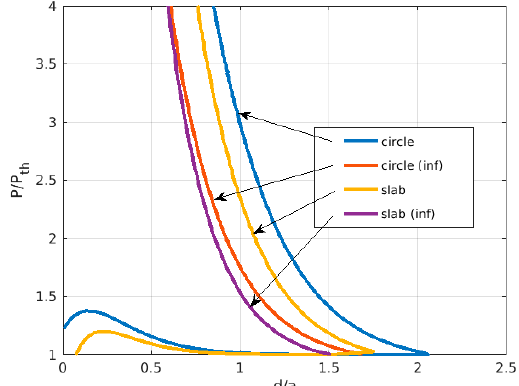
Figure 6. Stability boundaries in the plane of P / P th versus d / a for coupled circular cylindrical guides with v = 1.571. Curves labelled ‘inf’ are obtained using the values of overlap factors in the limit of large d / a . Figure 7. Stability boundaries in the plane of P / P th versus d / a for coupled circular cylindrical guides with v = 2.255.